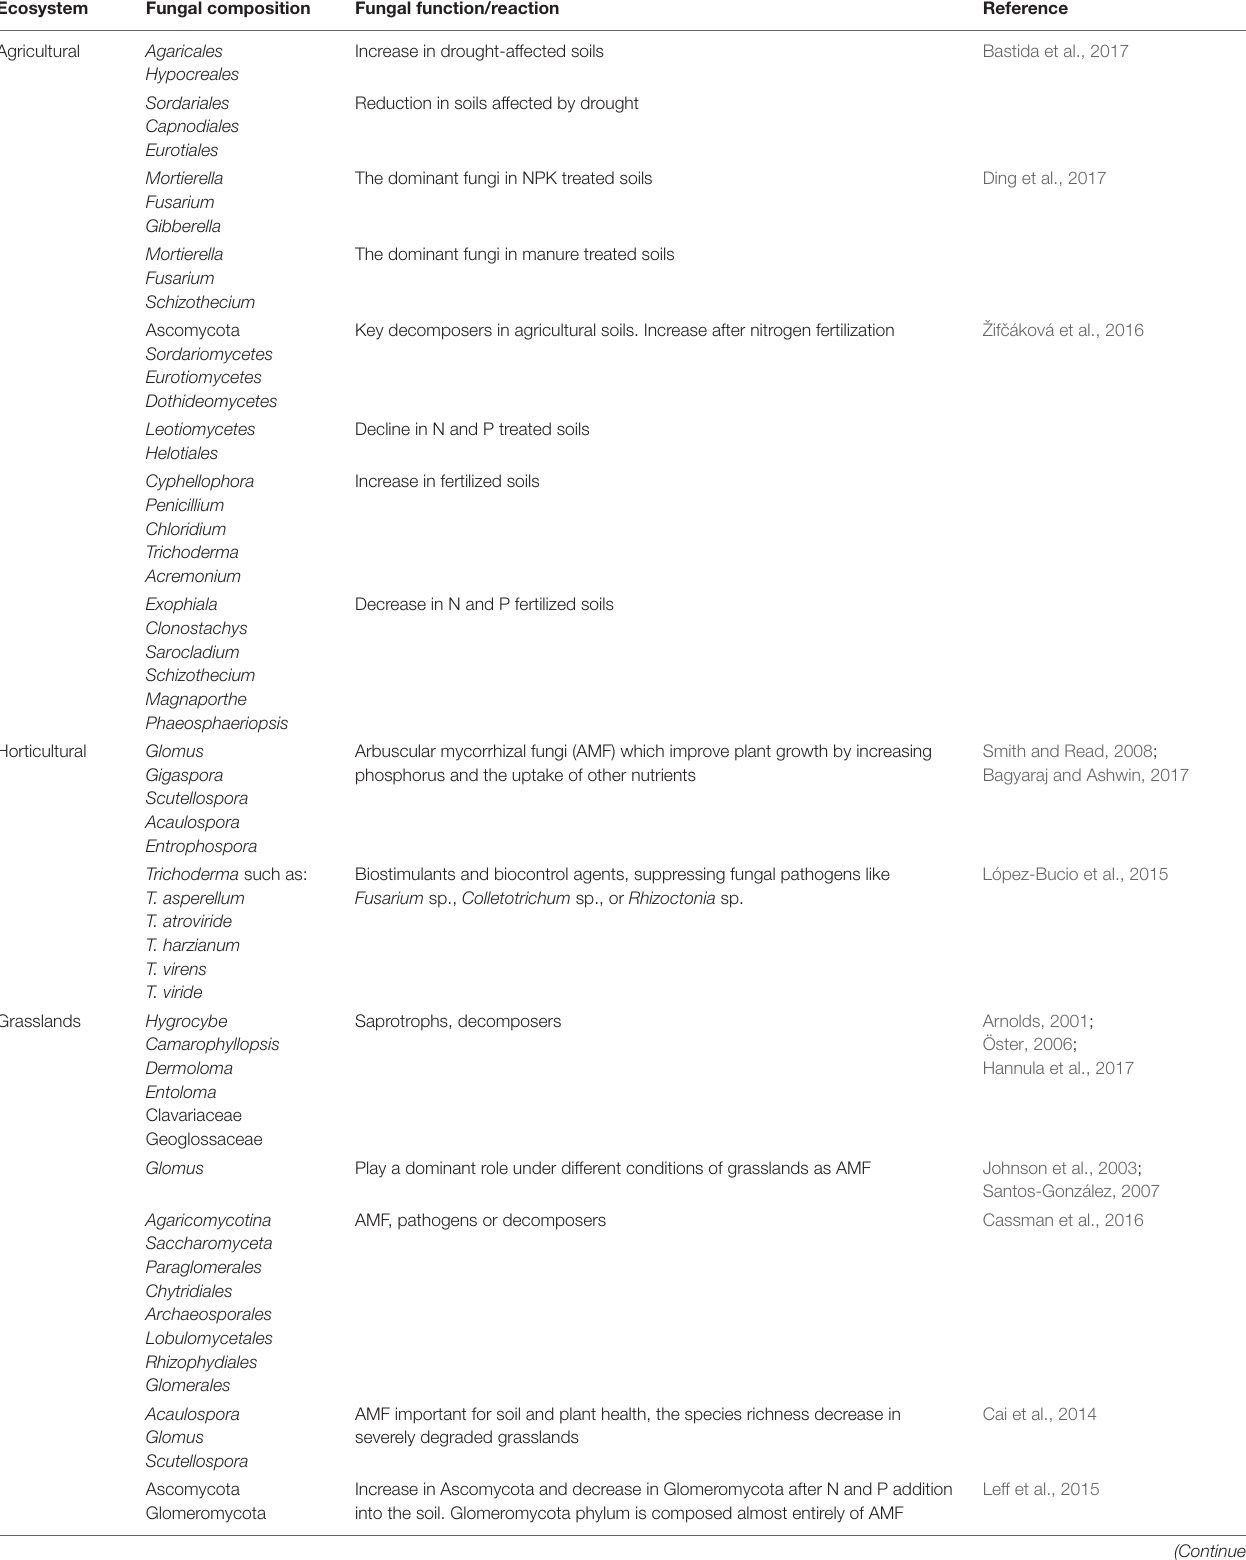
TABLE 1 | Fungal community composition in different soil ecosystems and their